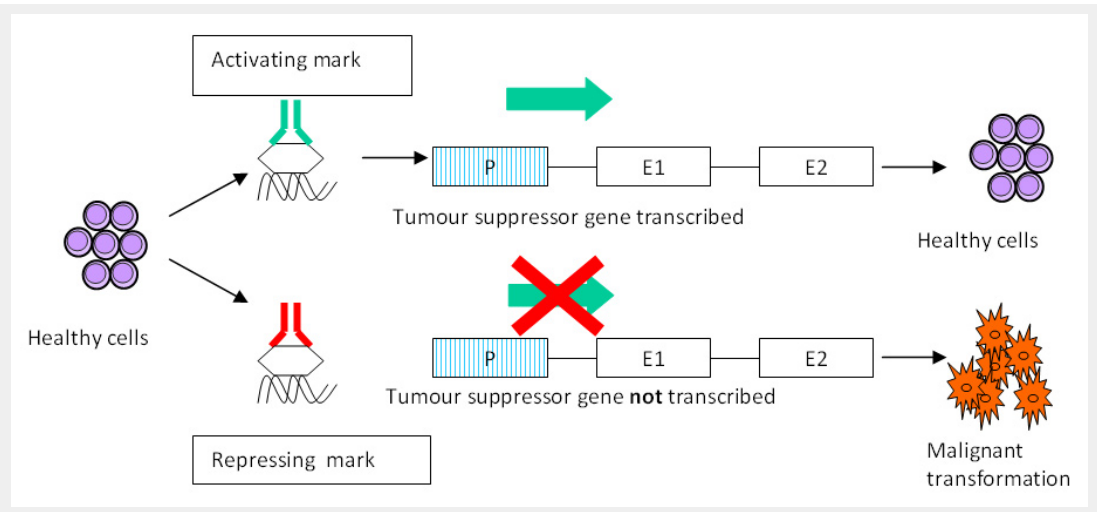
Figure 4 Schematic representation of epigenetics. Epigenetic changes mark the genome at specific sites acting as switches that determine whether a particular gene is transcribed (switch “on”) or not (switch “off”). In the figure an activating mark results in normal transcription of a tumour suppressor gene and maintenance of normal cell phenotype whilst a repressing mark in the same gene results in lack of transcription and malignant transformation of that cell line. Abbreviations: P: promoter; E: